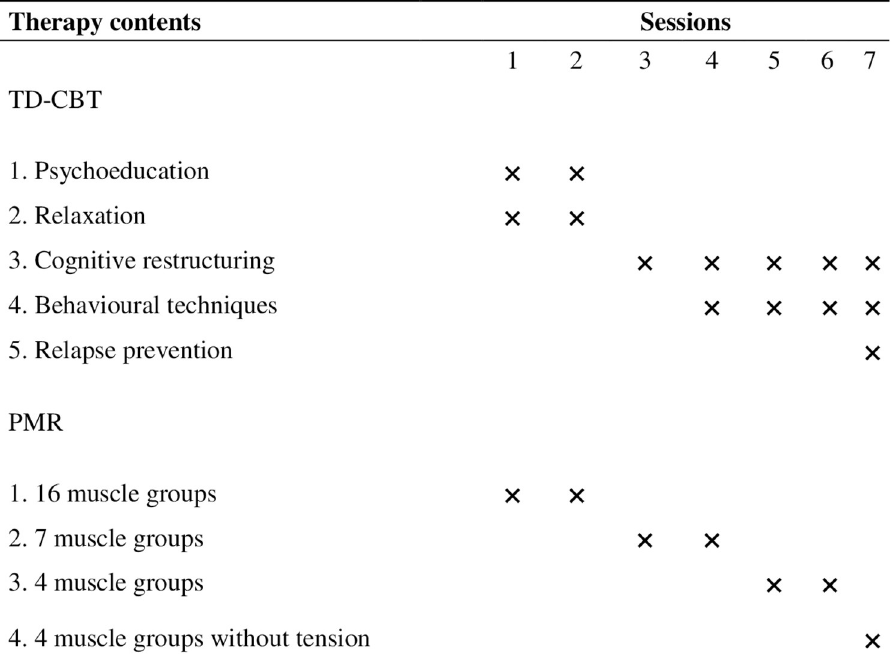
Fig 2. Session timeline for the TD-CBT and PMR